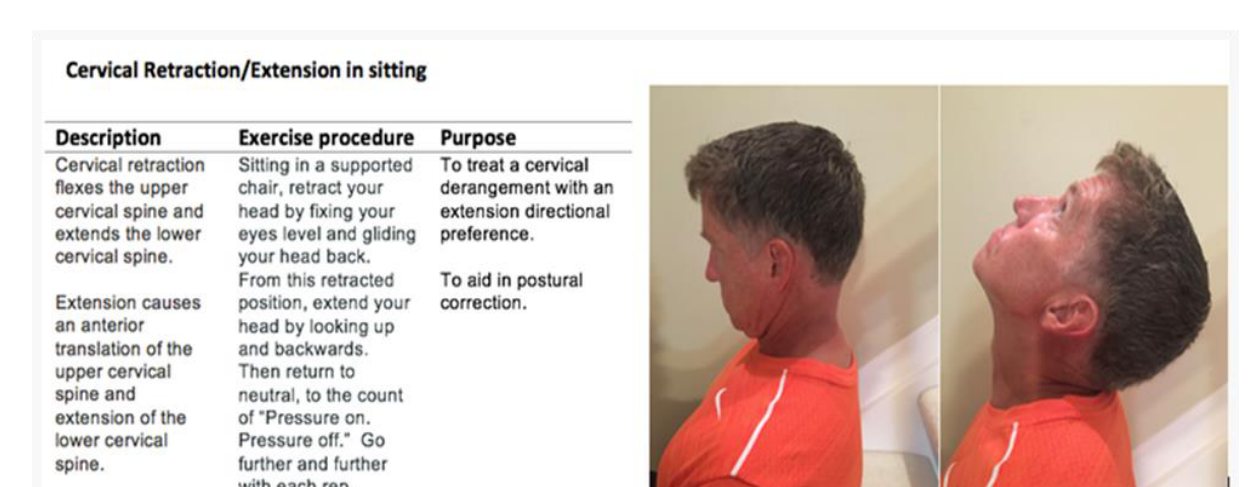
Figure 4. Cervical retraction/extension in